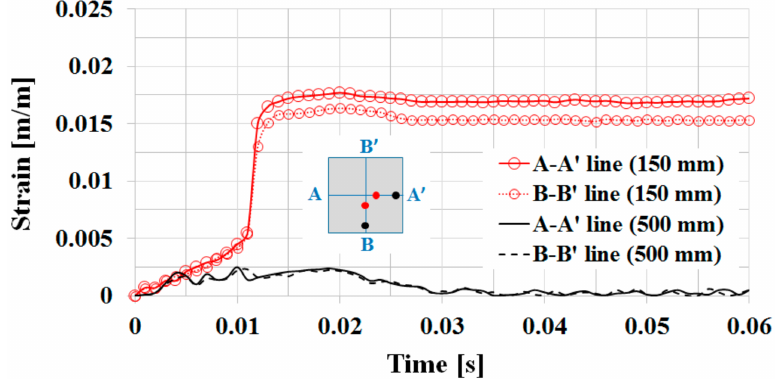
Figure 16. Specimen strain variation during the experiment (drop height of 3 m).